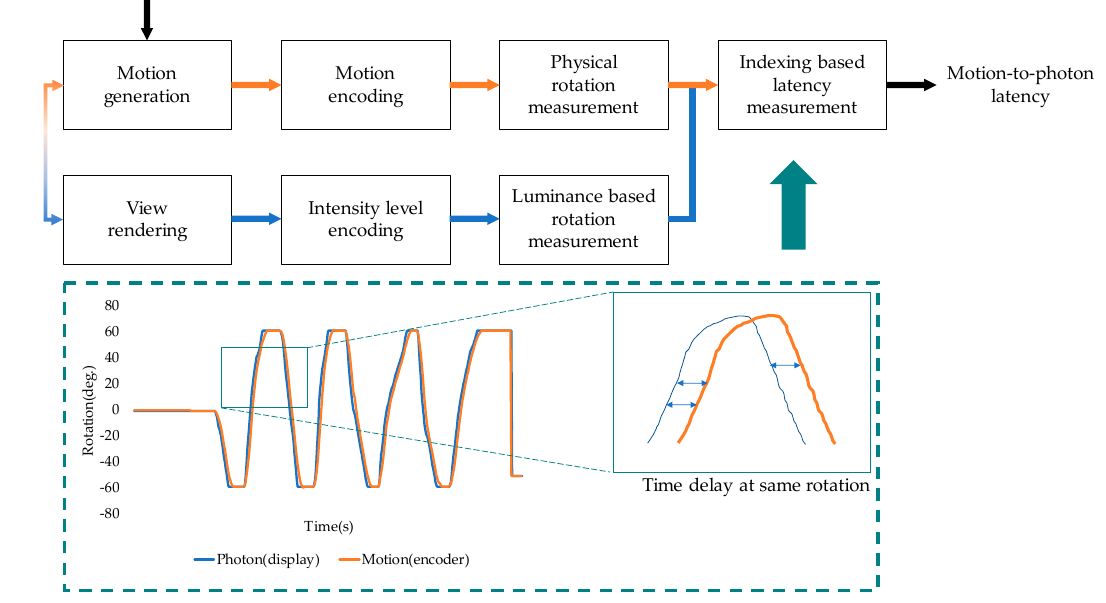
Figure 3. Overall block diagram of the proposed system.